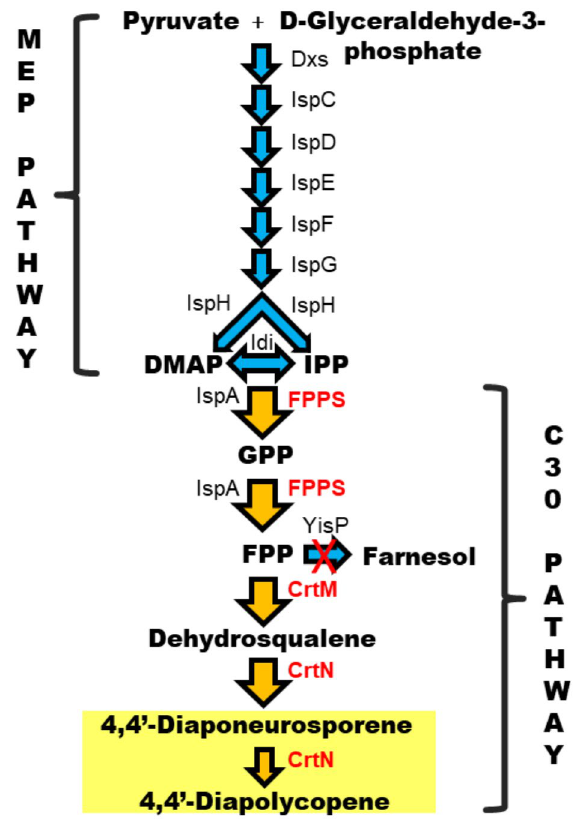
Fig. 1 Metabolic pathways associated with terpenoid biosynthesis in B. subtilis and engineering strategies for the production of yellow C 30 carotenoids 4,4’-diaponeurosporene and 4,4’-diapolycopene (C 30 path- way). Foreign genes are marked in red. Yellow arrows outlined in black indicate the reactions reinforced by chromosomic overexpression of the fpps gene (farnesyl diphosphate synthase) from B. megaterium DSM 319, crtM (squalene desaturase) and crtN (dehydrosqualene desaturase or di- apophytoene desaturase) genes from S. aureus , and deletion of the yisP (farnesyl diphosphate phosphatase) gene, yielding the C 30 carotenoid pigments 4,4’-diaponeurosporene and 4,4’-diapolycopene. Enzymes in the MEP (Methylerythritol 4-phosphate) pathway: 1-deoxy-D-xylulose- 5-phosphate synthase ( Dxs ); 1-deoxy-D-xylulose-5-phosphate